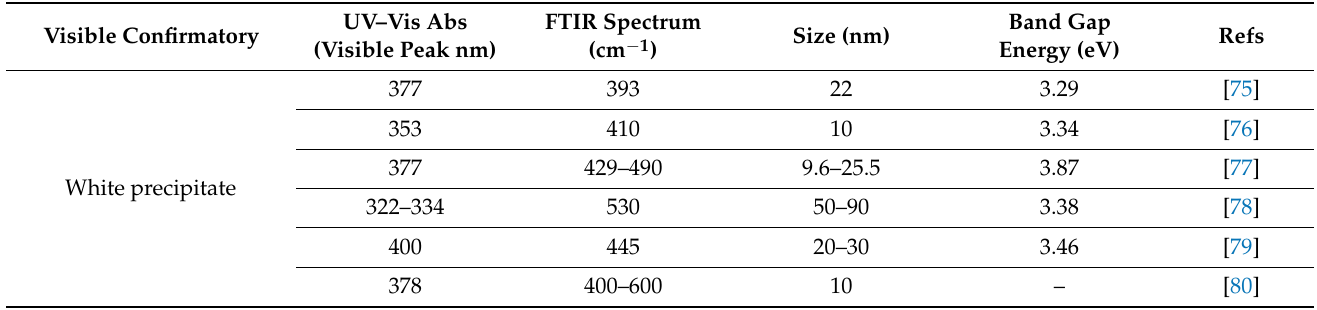
Table 2. Characterization of specific ZnONPs produced through biological